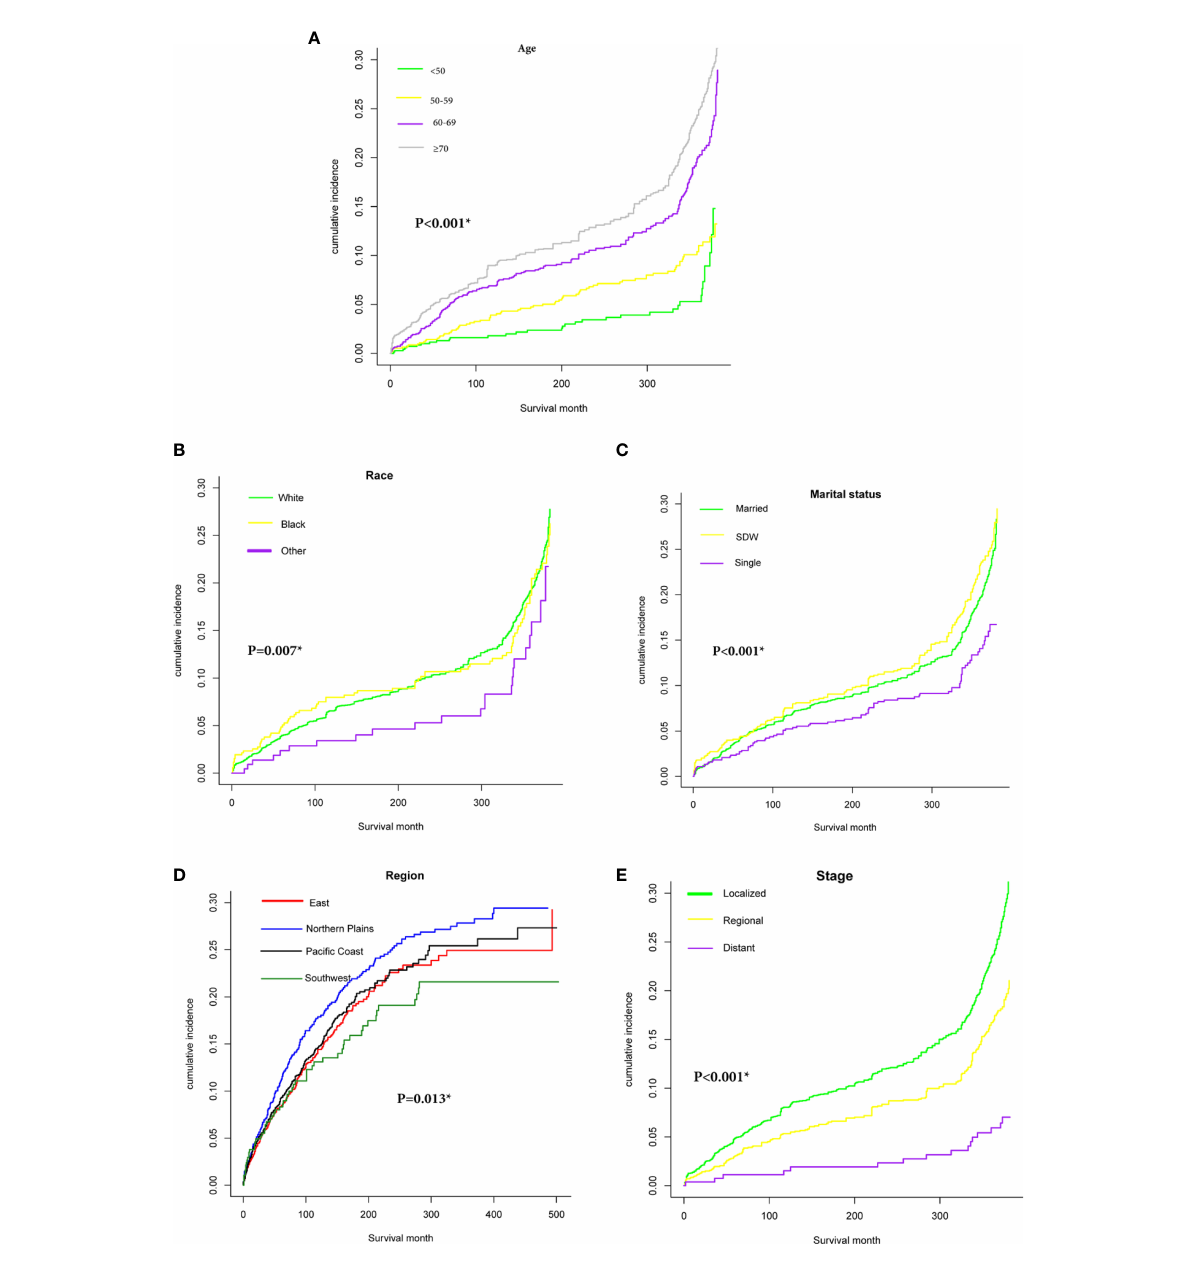
FIGURE 2 Cumulative incidence function curve of PSCC patients after adjust for multivariate. Cardiovascular diseases (CVD)-speci fi c death: (A) age ( ≤ 50, 50-59, 60-69, ≥ 70); (B) Race (white, black, other); (C) Marital status (Married, SDW, Single); (D) : Region (East, Northern Plains, Paci fi c Coast, Southwest); (E) Stage (Localized, Regional,